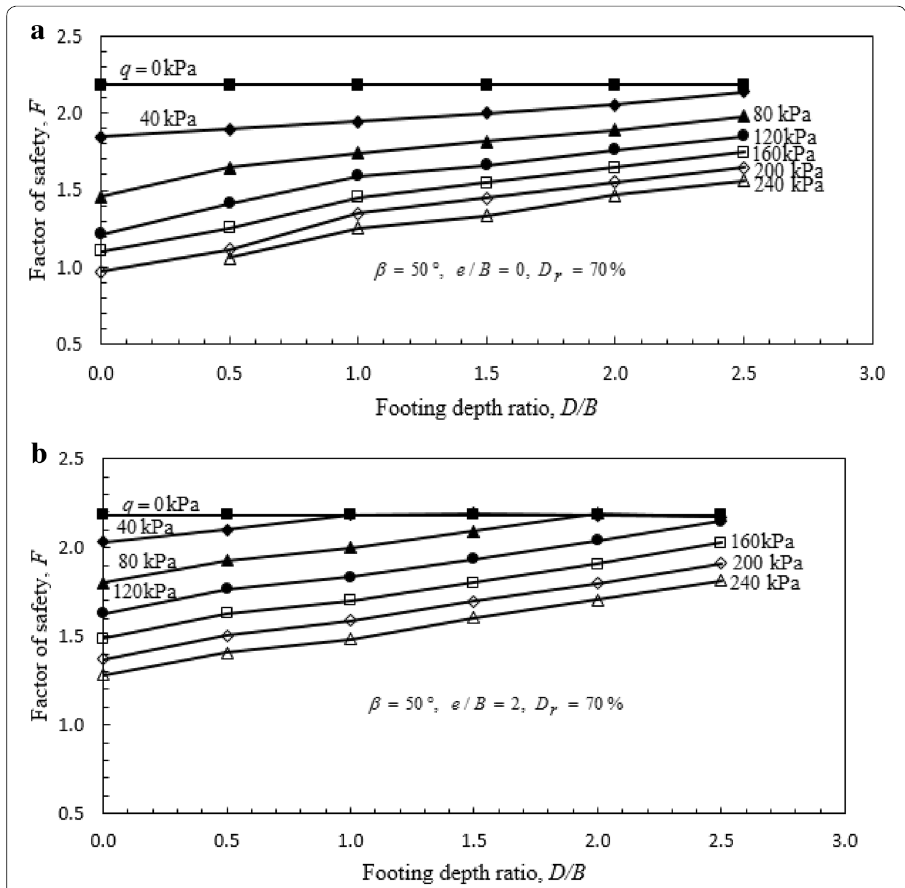
Fig. 7 Variation of factor of safety, F , with footing depth ratio D / B for 50° slope: a e / B = 0 , b e / B =